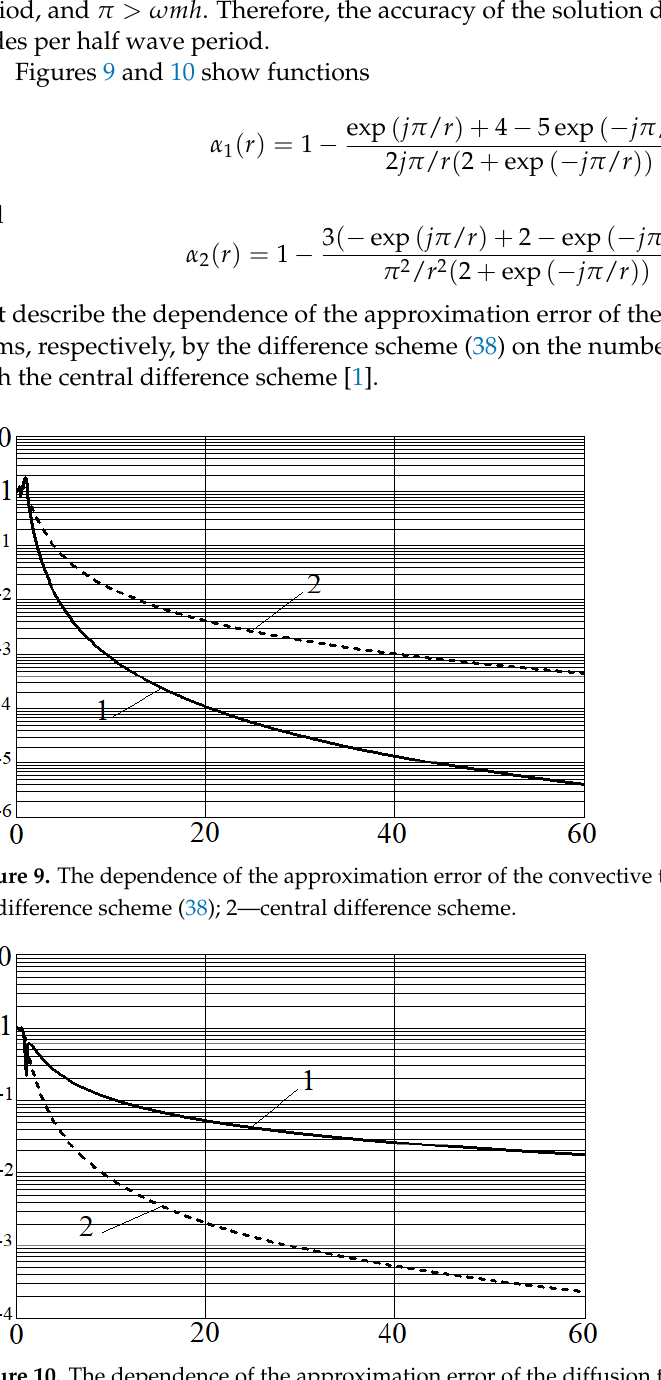
Figure 10. The dependence of the approximation error of the diffusion term on the number of nodes: 1—difference scheme (38); 2—central difference